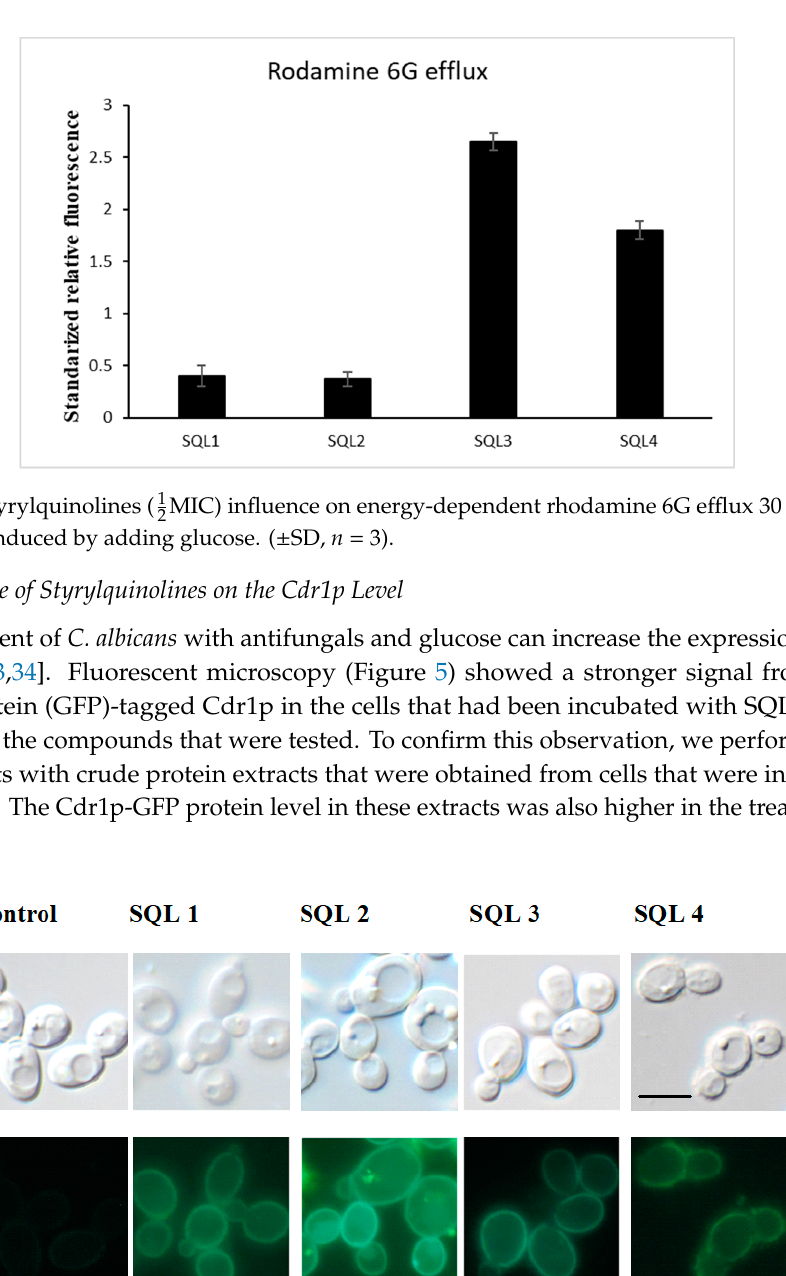
Figure 6. Cdr1p-GFP protein levels in crude protein extracts of the cells after treatment with styrylquinolines (½MIC) as was evidenced by the anti-GFP Western blot ( n = 4); DMSO-treated C. albicans cells were used as the control. Among them, SQL 2 was the most effective inductor of Cdr1p-GFP protein synthesis followed by SQL 1 and SQL 4 . On the other hand, SQL 3 caused reduction in Cdr1p-GFP protein level in the cells. 3. Discussion Based on our experience with SQLs, we decided to use acetylation as the protection of hydroxyl groups. Although hydrolysis of acetoxy group may be rapid, it depends on structure and condition [35]. The same can be found in enzyme-dependent hydrolysis as in lipases present in Candida spp. [36]. We found that acetylated styrylquinolines are rather resistant to decomposition in solvent and in the cell. The same was reported also in mammalian cells during in vitro examination of anticancer activity [9,37]. Even during prolonged (96 h) incubation, derivatives with hydroxyl groups are more than ten times active than their acetylated representatives. Moreover, low yield of SQL 2 (15%) can